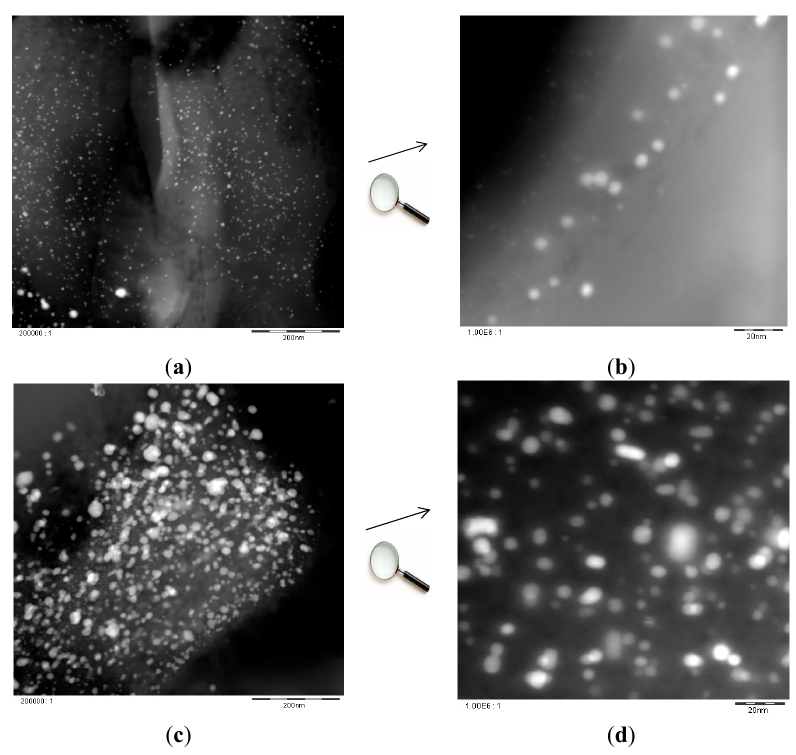
Figure 4. HAADF-STEM images of Au/silicalite-1 catalysts: ( a ) cat I (0.5%Au/silicalite-1 doped with CH 3 COOK/Au = 20), enlargement 200,000:1; ( b ) cat I, enlargement 1,000,000:1; ( c ) cat M (16.3% Au/silicalite-1 doped with CH 3 COOK/Au = 20), enlargement 200,000:1; and ( d ) cat M, enlargement 1,000,000:1.